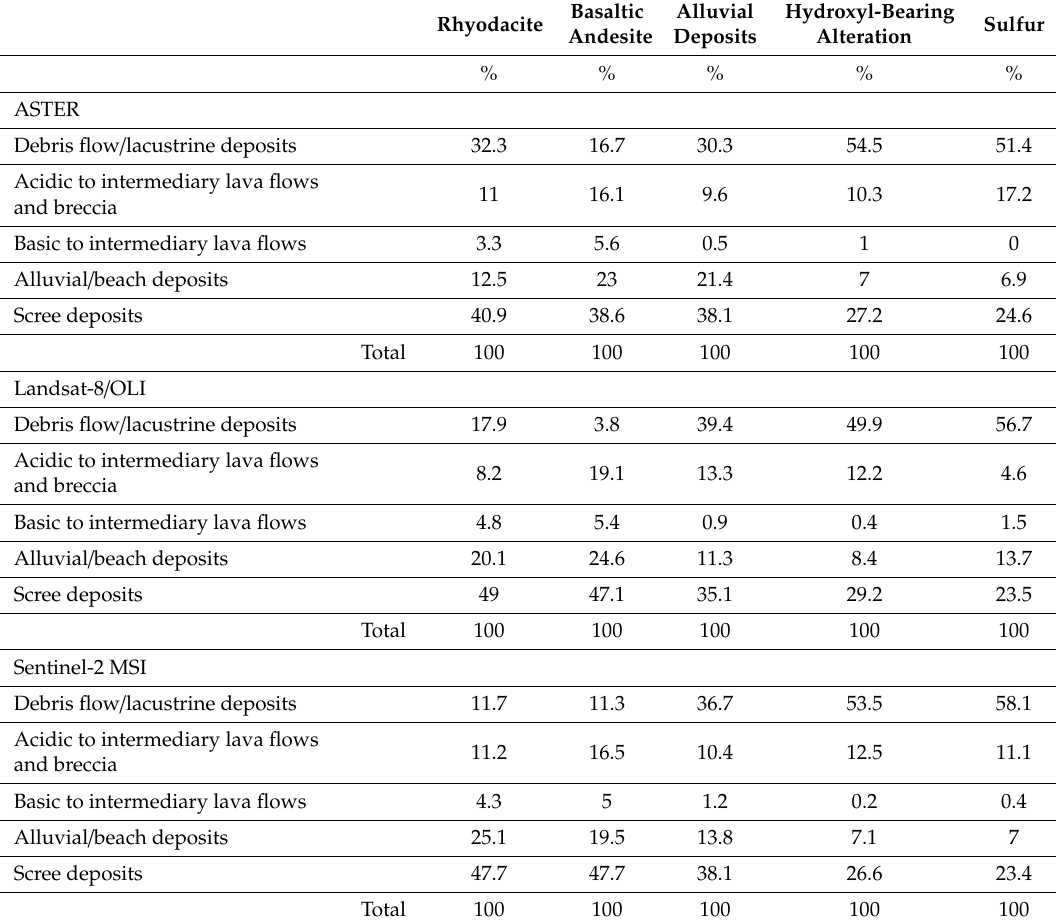
Basaltic Alluvial Rhyodacite Andesite Deposits